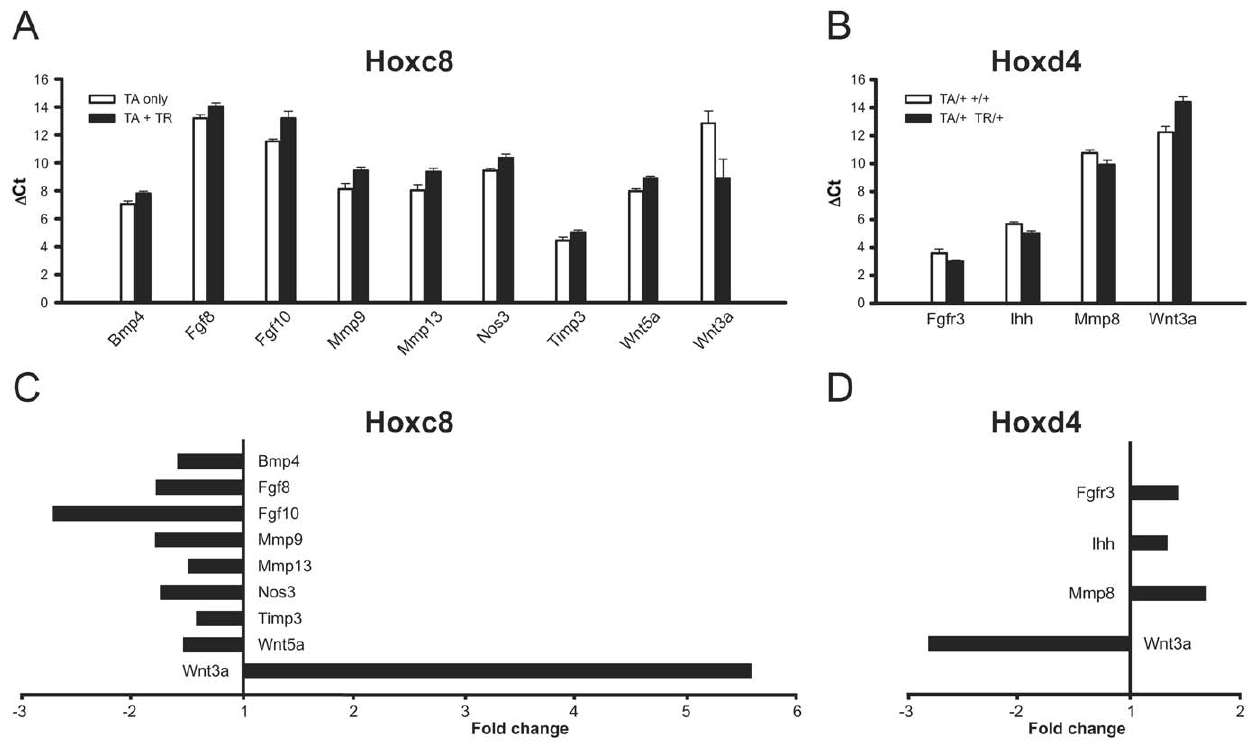
Figure 2. Altered gene expression levels in Hoxc8- and Hoxd4-transgenic cartilage. D C T values (normalized to endogenous control Gapdh) were averaged for each investigated gene over the control group as well the Hoxc8-transgenic group ( A , C ) and the Hoxd4-transgenic group ( B , D ), respectively, and are plotted as mean 6 standard error of the mean (SEM). Student’s T-test was performed to confirm statistical significance (p , 0.05). Higher D C T values were found for Bmp4, Fgf8, Fgf10, Mmp9, Mmp13, Nos3, Timp3, and Wnt5a ( A , filled bars) in Hoxc8-transgenic animals, indicating lower expression levels compared to littermate controls ( A , open bars). Wnt3a expression was higher (lower D C T value) in Hoxc-transgenic chondrocytes compared to controls. Lower D C T values were found for Fgfr3, Ihh and Mmp8 ( B , filled bars) in Hoxd4-transgenic animals, indicating higher expression levels compared to littermate controls ( B , open bars). Wnt3a expression levels are lower in Hoxd4-transgenic chondrocytes (higher D C T value) compared to the control group. Figures C and D present the relative fold-change using the comparative C T method based on amplification efficiency for each gene (see Methods),